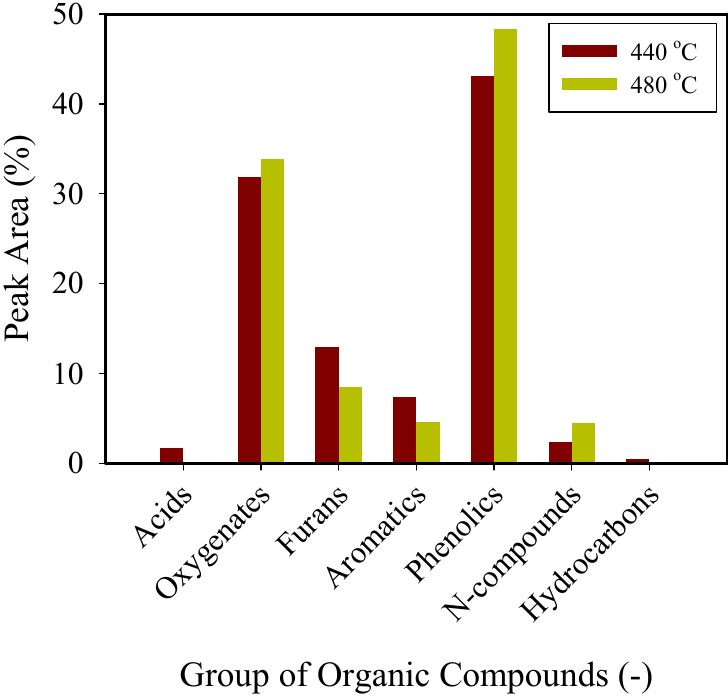
Figure 7. Distribution of organic compounds formed in bio-oil (0.8 kg / h feeding rate, 15 L / min N 2 carrier gas flow rate).